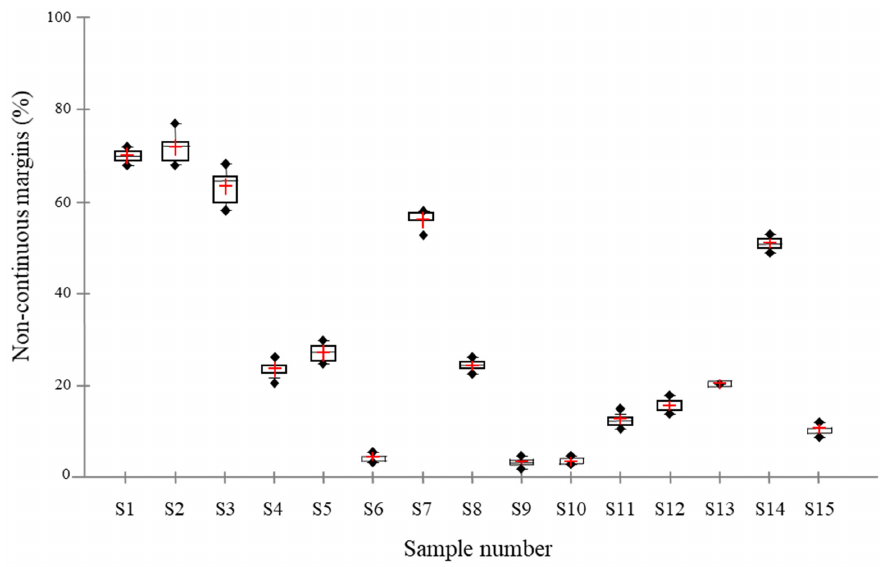
Figure 3. Box plot showing the percentage of noncontinuous margins (% NCM) for each of the fifteen class V cavities (S1–S15, S: samples) from pictures recorded with optical microscopy. The marginal analysis was repeated ten times with the same operator. Red cross: mean, dashed line: median, ⬩ : Outliers.